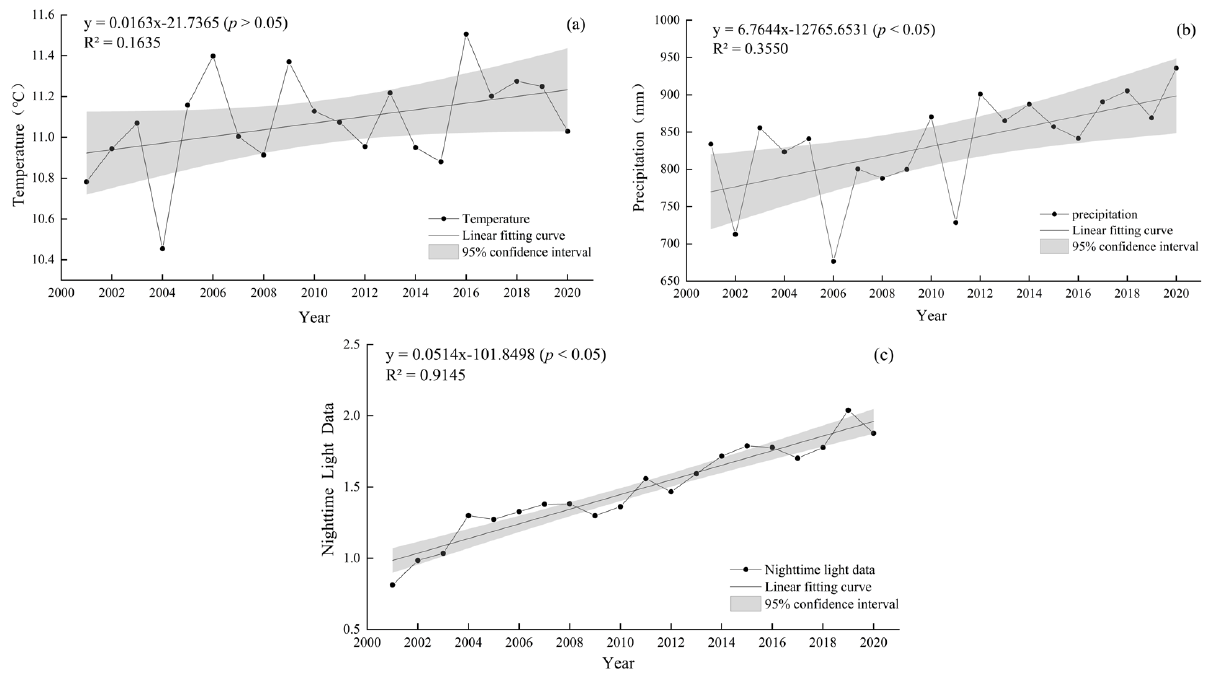
Figure 6. Annual variation trend of temperature ( a ), precipitation ( b ) and nighttime light index ( c ) in the Minjiang River Basin from 2001 to 2020.